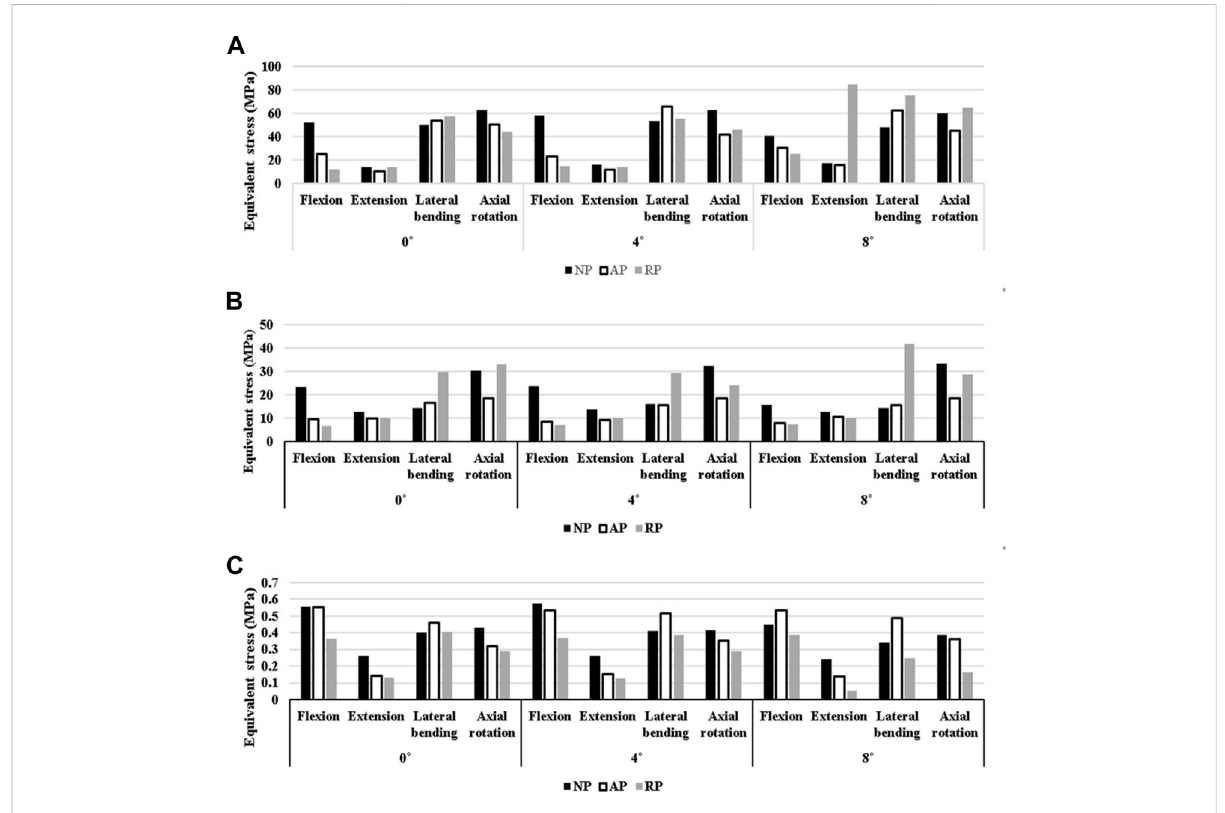
FIGURE 10 N Equivalent stress at each part. (A) at Screw-Spinal rod (B) at peri-implant (C) at L5 upper